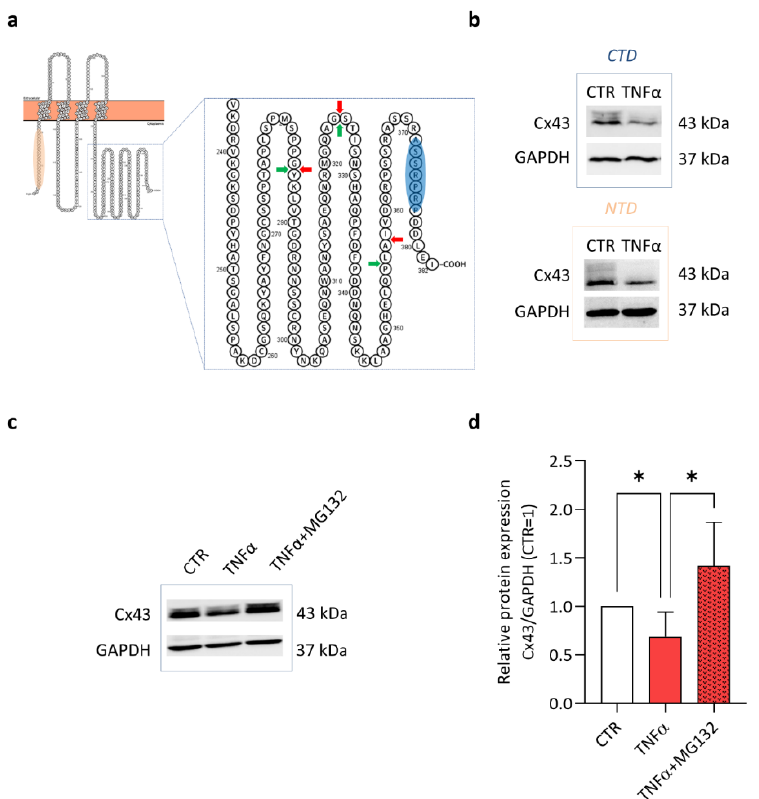
Figure 2. Cx43 cleavage and proteasomal degradation in TNF α -treated CH. ( a ) Schematic amino acid sequence of Cx43 (https://wlab.ethz.ch/protter/# (accessed on 15 March 2021)). The major 3 MMP-3 and -13 cleavage sites at the CTD, predicted by in silico analysis (https://www.dmbr.ugent.be/prx/bioit2-public/SitePrediction/ (accessed on 15 March 2021)), are shown as red and green arrows, respectively. The area surrounding Arg376, the recognized epitope of the CTD antibody, is highlighted in blue, while the one at the NTD is in orange. ( b ) Representative immunoblot of CTR and TNF α -treated CH at day 3 with specific band for Cx43 revealed by Ab raised against epitope at either CTD or NTD. ( c , d ) Western blot analysis of Cx43 expression in CH pre-treated for 1 h with MG-132 and then stimulated with TNF α for 24 h. ( c ) Representative immunoblot is shown. ( d ) Quantification of Cx43 expression. Data ( n = 7 independent experiments) were normalized on GAPDH and expressed as relative values (CTR = 1). Statistical analysis was performed by one-way analysis of variance (ANOVA) using Tukey’s post hoc test. Significance is shown as * p < 0.05. CTD: C-terminal domain, CTR: control (untreated), Cx43: connexin 43, GAPDH, Glyceraldehyde-3-Phosphate Dehydrogenase, MMP: matrix metalloproteinase, NTD: N-terminal domain, TNF α : tumor necrosis factor alpha.